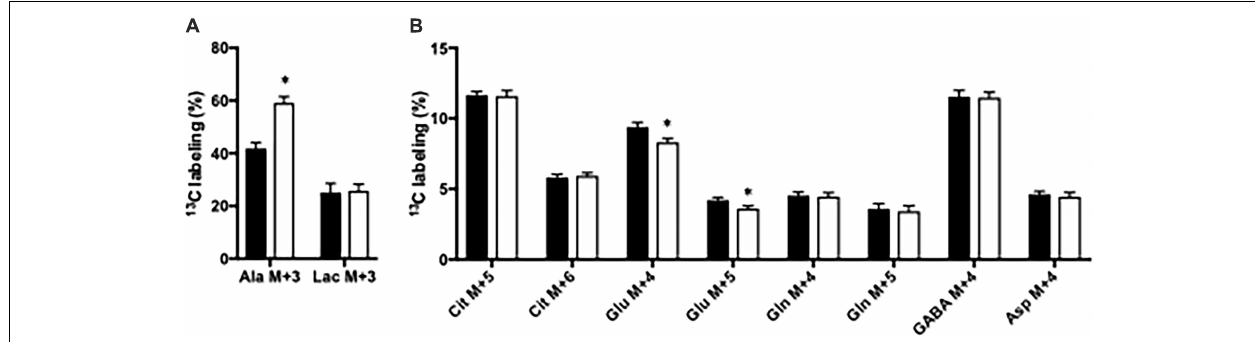
FIGURE 1 | The percent 13 C labeling in metabolites in hippocampal slices from Glud1 lox / lox (filled bars) and CNS- Glud1 − / − (open bars) mice following metabolism of [U- 13 C]glucose via subsequent turns in the TCA cycle. Percent of alanine and lactate being M + 3 labeled (A) and the percent of citrate M + 5, citrate M + 6, glutamate M + 4, glutamate M + 5, glutamine M + 4, glutamine M + 5, GABA M + 4, and aspartate M + 4 (B) . Hippocampal slices from Glud1 lox / lox and CNS- Glud1 − / − mice were incubated in the presence of [U- 13 C]glucose for 60 min as detailed in Materials and methods. The enrichment was determined from GC-MS analysis of slice extracts as detailed in Materials and methods. Results are averages ± SEM ( n = 10), and the asterisk indicates a statistically significant